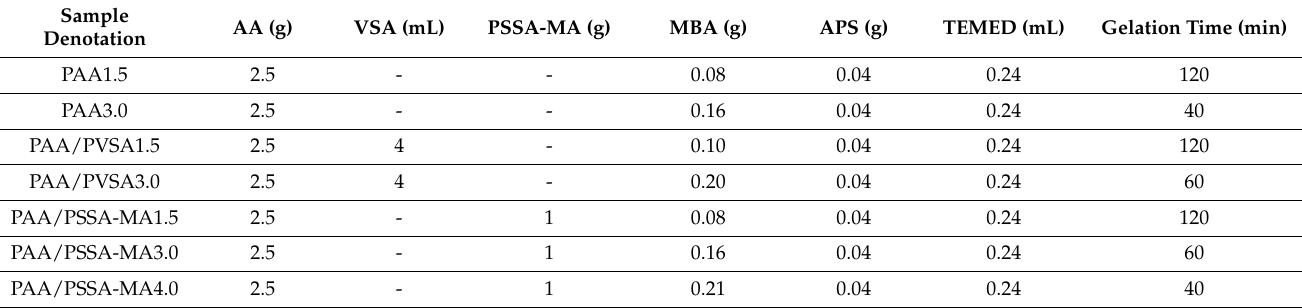
Table 1. The composition of AA, VSA and PSSA-MA in the PAA, PAA/PVSA, PAA/PSSA-MA hydrogels. The numbers in the sample denotations indicate the molar crosslinker